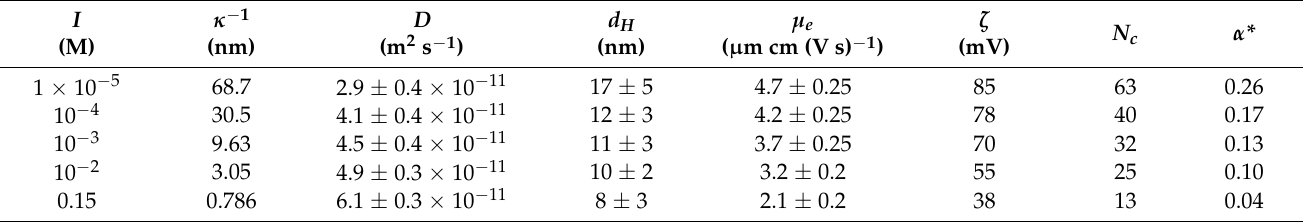
Table 5. Physicochemical characteristics of P-Arg used in experimental studies, T = 298 K, pH